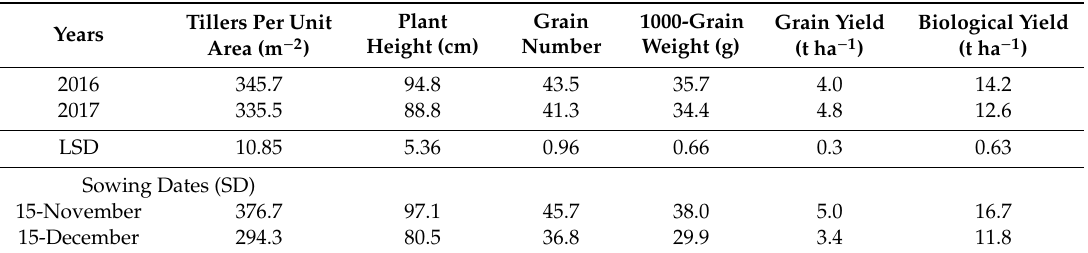
Table 3. Mean comparison of the e ff ect of seed priming and sowing dates on yield and yield traits of wheat. In the formatted paper this table was missing so I insert